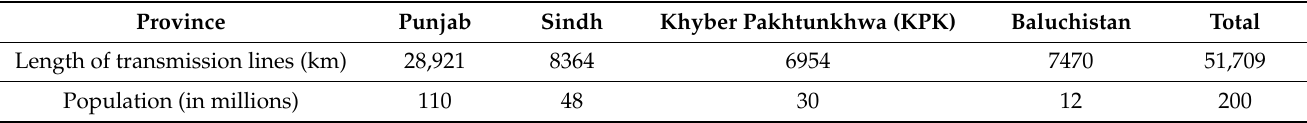
Table 2. Length of transmission lines (in kilometers) and population (in a million) for the four provinces in Pakistan. Province Punjab Sindh Khyber Pakhtunkhwa (KPK) Baluchistan Total Length of transmission lines (km) 28,921 8364 6954 7470 51,709 Population (in